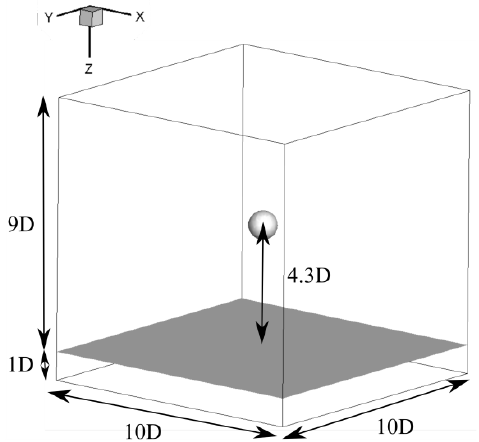
Figure 9. Computational domain. The white object and gray plate represent particle and flat wall, respectively.